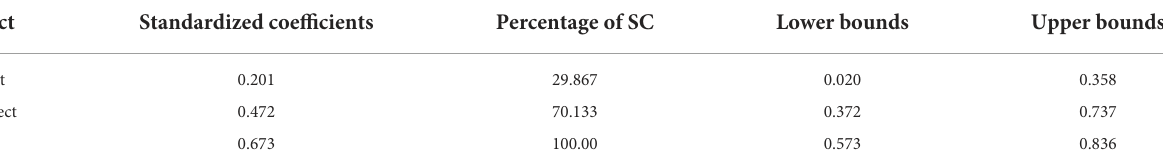
TABLE 4 Decomposition of mediating effects of policy